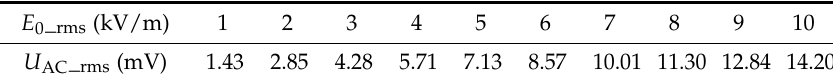
Table 1. U AC_rms obtained under different E 0_rms .